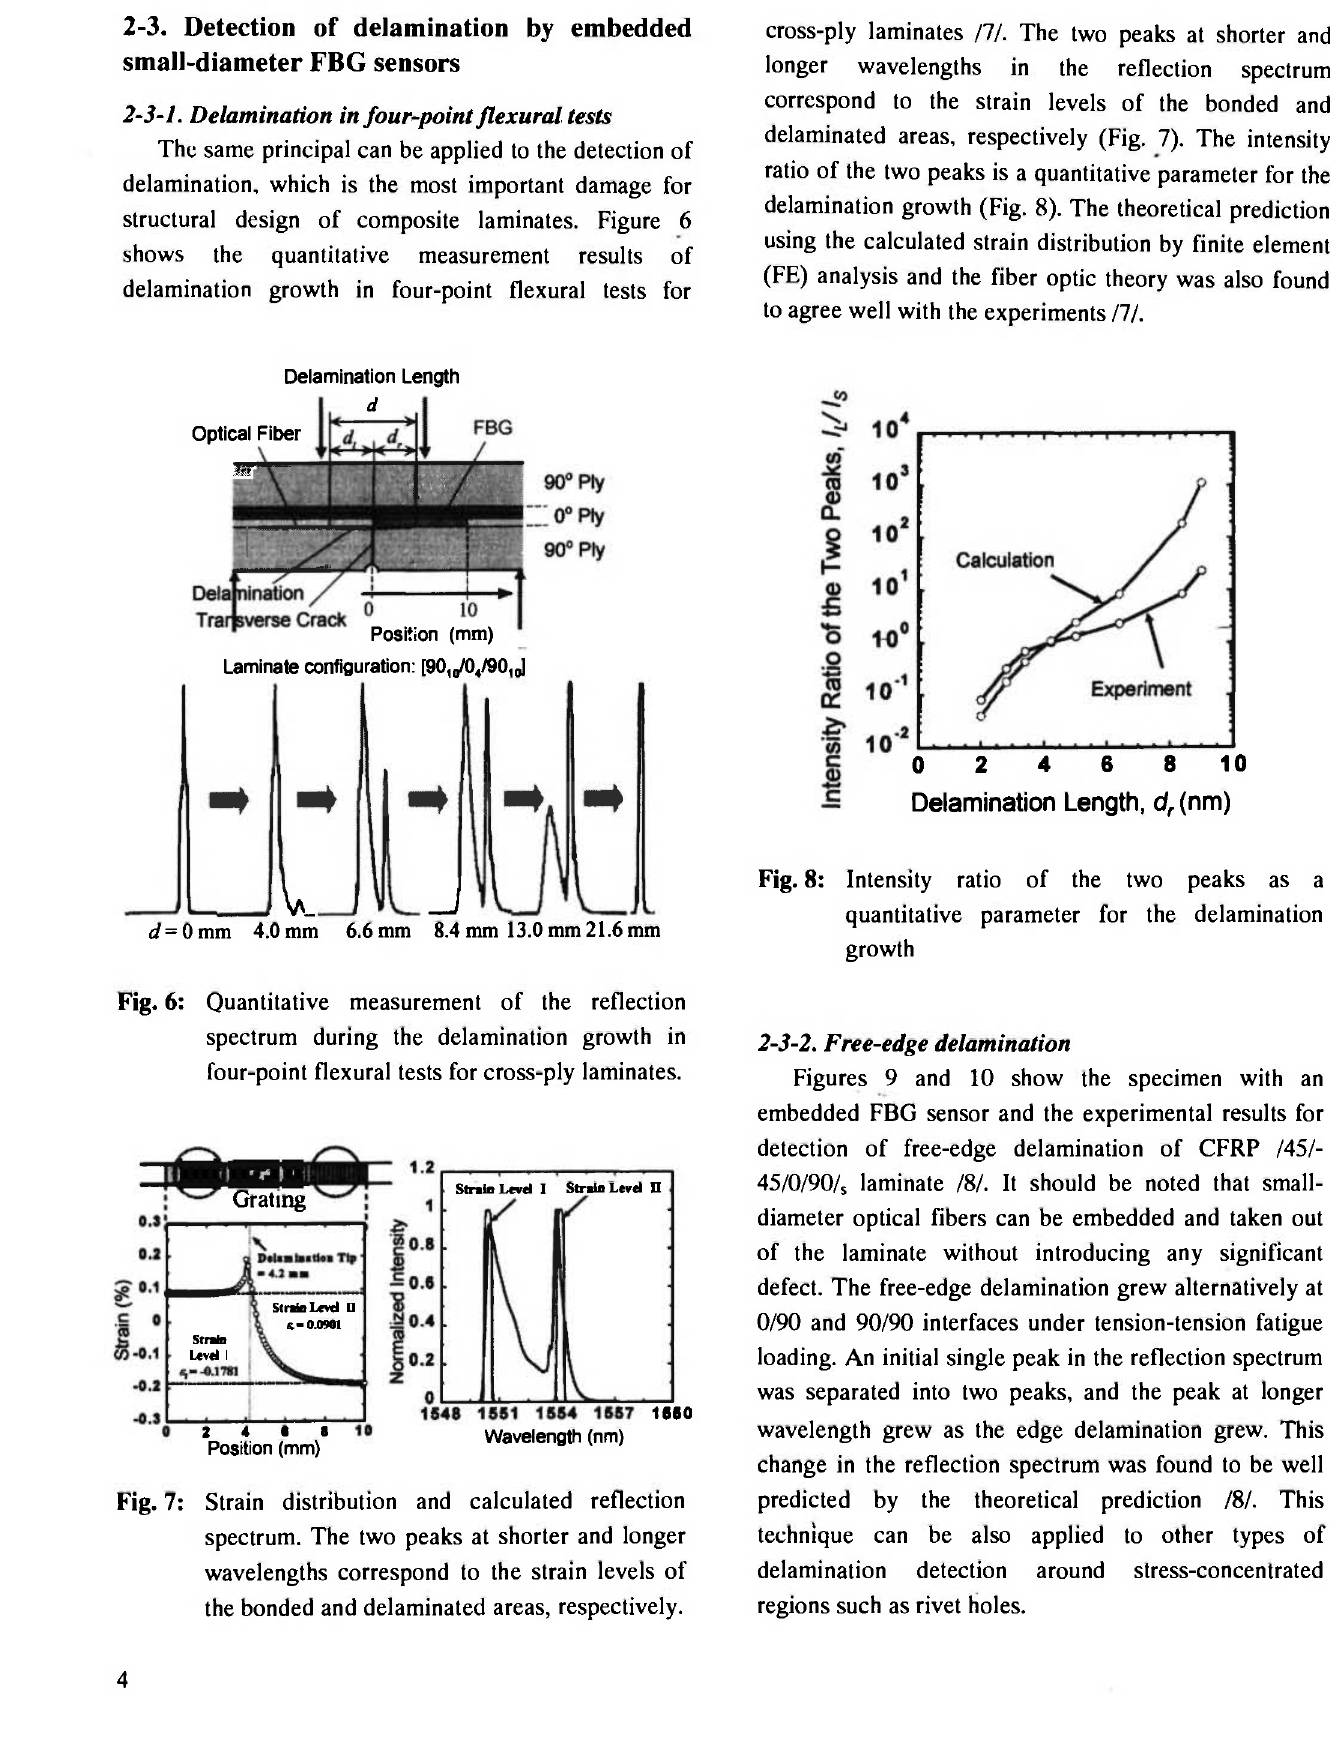
Fig. 7: Strain distribution and calculated reflection spectrum. The two peaks at shorter and longer wavelengths correspond to the strain levels of the bonded and delaminated areas, respectively.